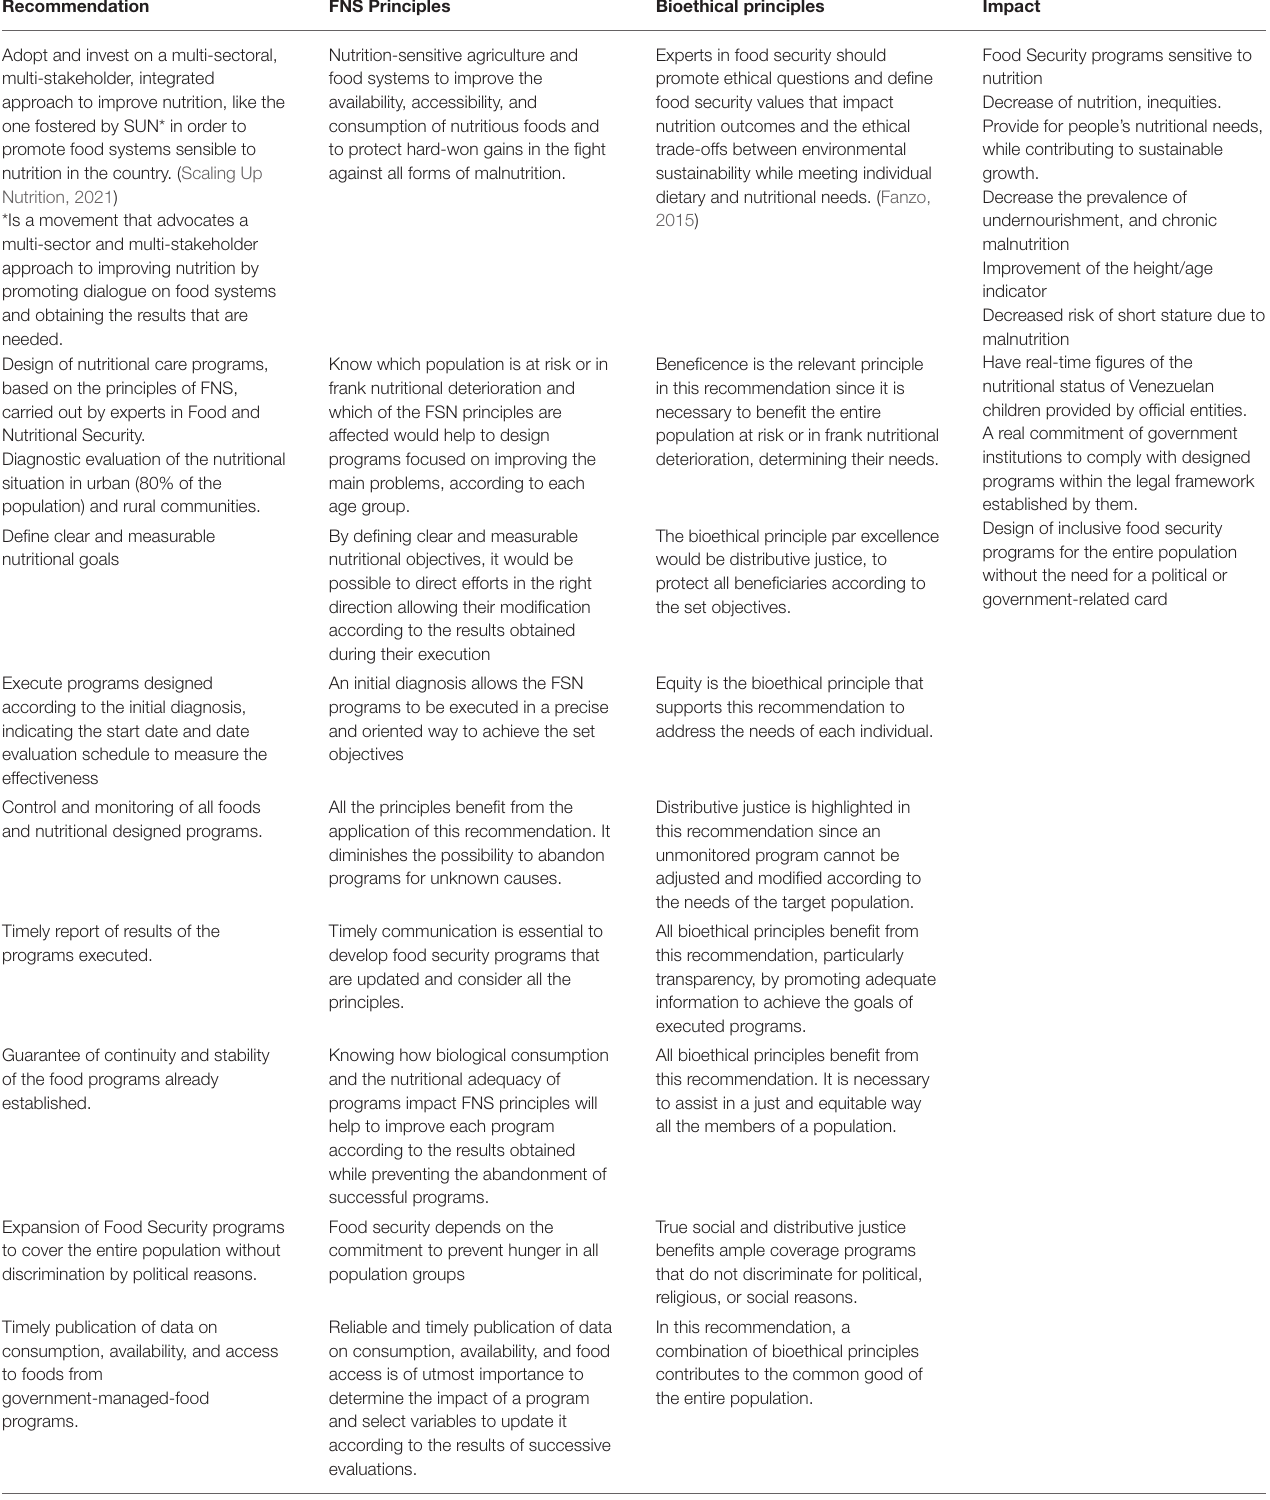
TABLE 2 | Recommendations for improvement of food security in Venezuela based on the principles of the food security and bioethics.